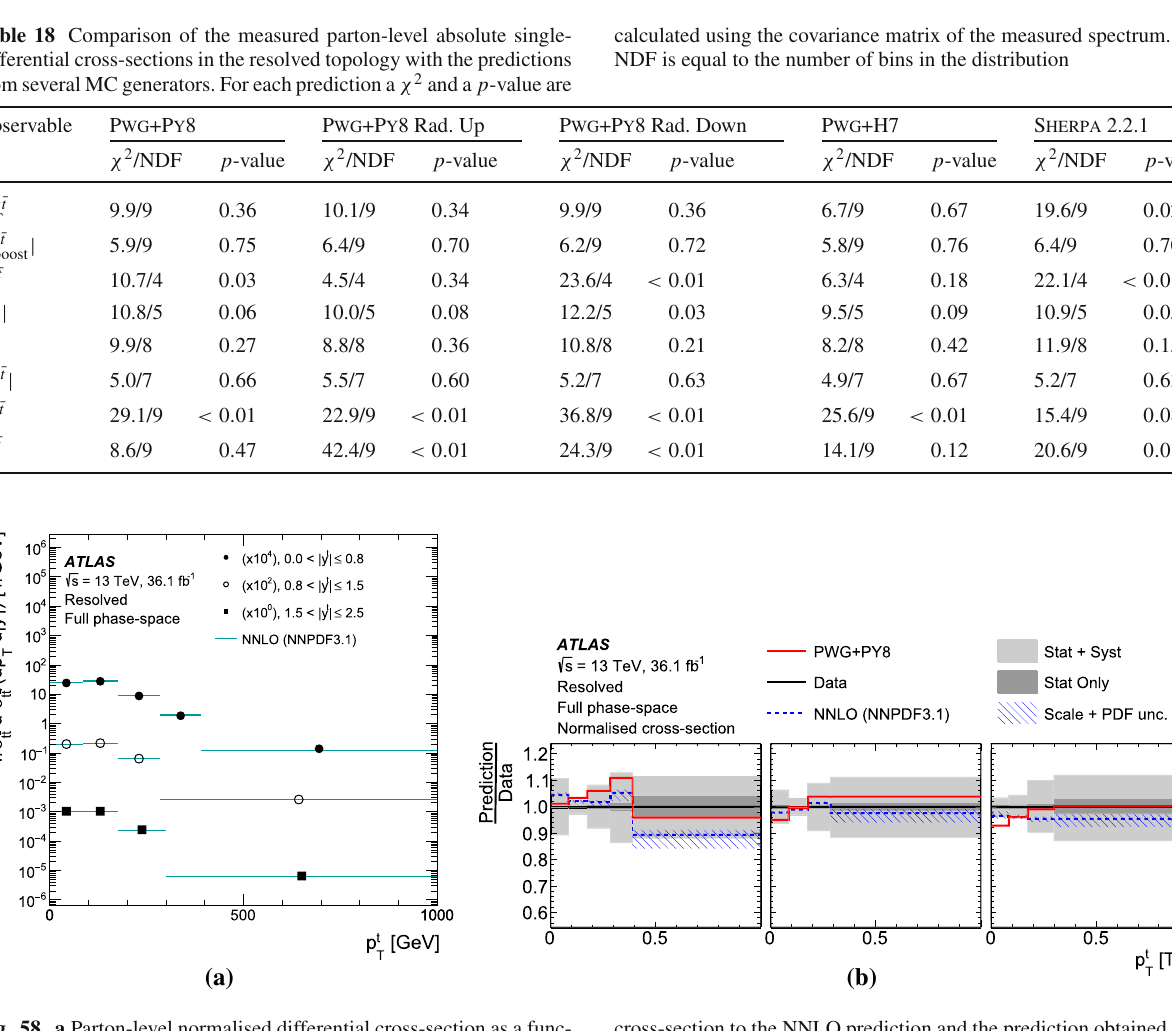
cross-section to the NNLO prediction and the prediction obtained with the Powheg + Pythia8 MC generator. The hatched band represents the total uncertainty in the NNLO prediction. The solid bands represent the statistical and total uncertainty in the